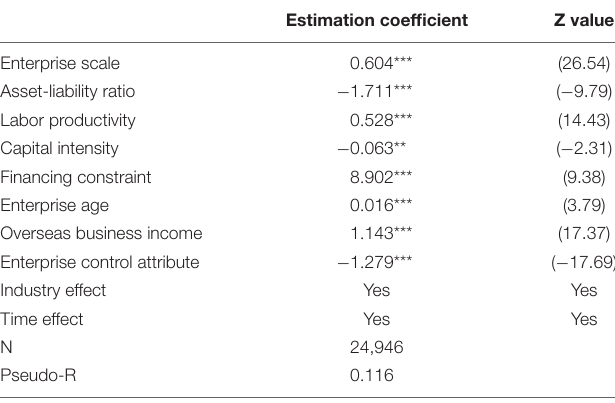
TABLE 3 | Regression results of Logit